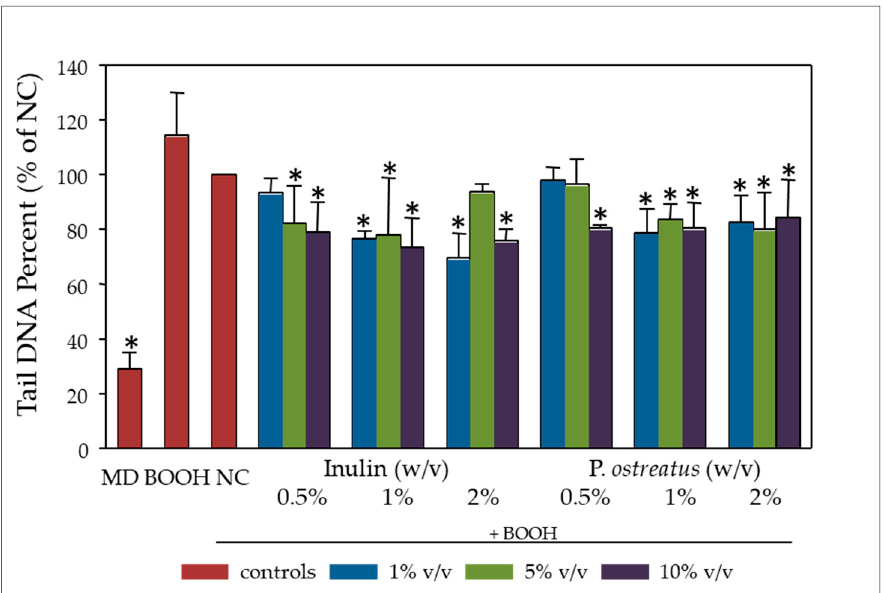
Figure 3. Genoprotective effect of fermentation supernatants (FSs): Fermentations were performed at increasing concentrations 0.5%, 1% and 2% w/v inulin or lyophilized P. ostreatus 1123 and with no additional carbohydrate source (NC) as a control. Caco-2 cells were incubated with NC, inulin (INU) and P. ostreatus (PO) FS at 1%, 5% and 10% v / v of culture medium for 48 h. The genotoxic agent tert-butyl hydroperoxide (BOOH) (500 µ M) was added one hour prior to harvesting. Cells in medium (MD) and cells treated only with BOOH were used as negative and positive controls, respectively. All values are expressed as the mean ± SD of two independent experiments. * p < 0.05 versus NC. NC: basal medium with no additional carbohydrate source. Associations were not significant unless otherwise indicated.